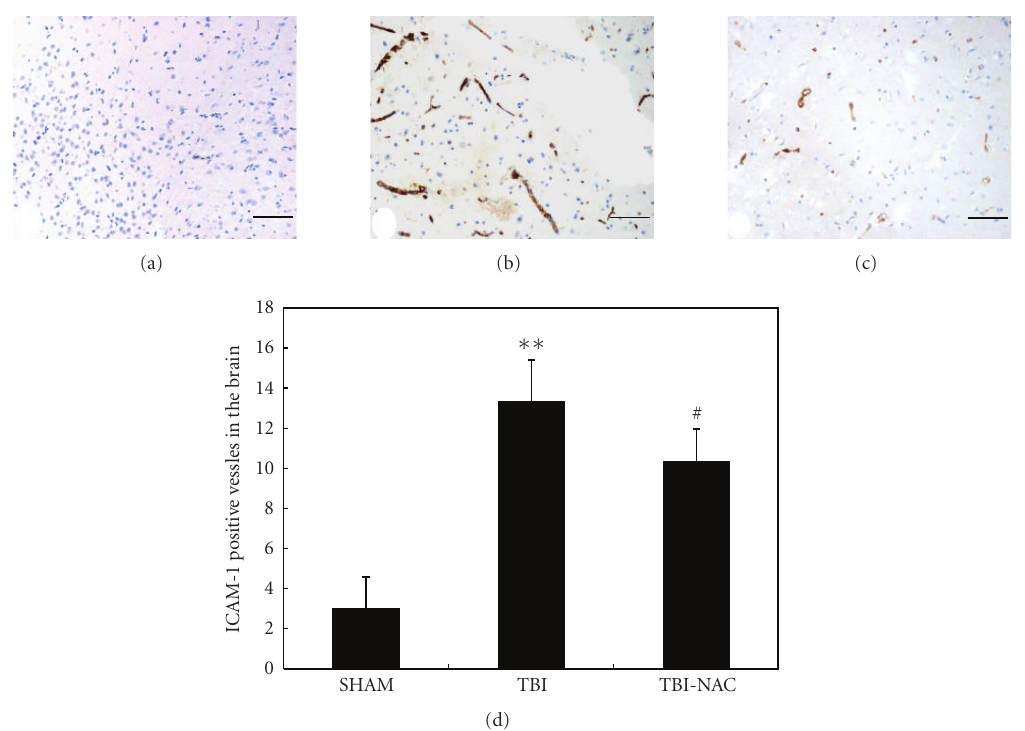
Figure 4: ICAM-1 immunohistochemistry in the injured cortex in SHAM group ( n = 5), TBI group ( n = 6), and TBI-NAC group ( n = 6). (a) SHAM rats showing few ICAM-1 positive vessels. (b) TBI rats showing strong ICAM-1 positive vessels stained as brown. (c) TBI-NAC rats showing less ICAM-1 positive vessels than TBI rats (scar bar, 50 μ m). (d) Administration of NAC remarkably inhibited TBI-induced upregulation of ICAM-1 expression on cerebrovascular endothelia. ∗∗ P < . 01 versus SHAM group; # P < . 05 versus TBI group.